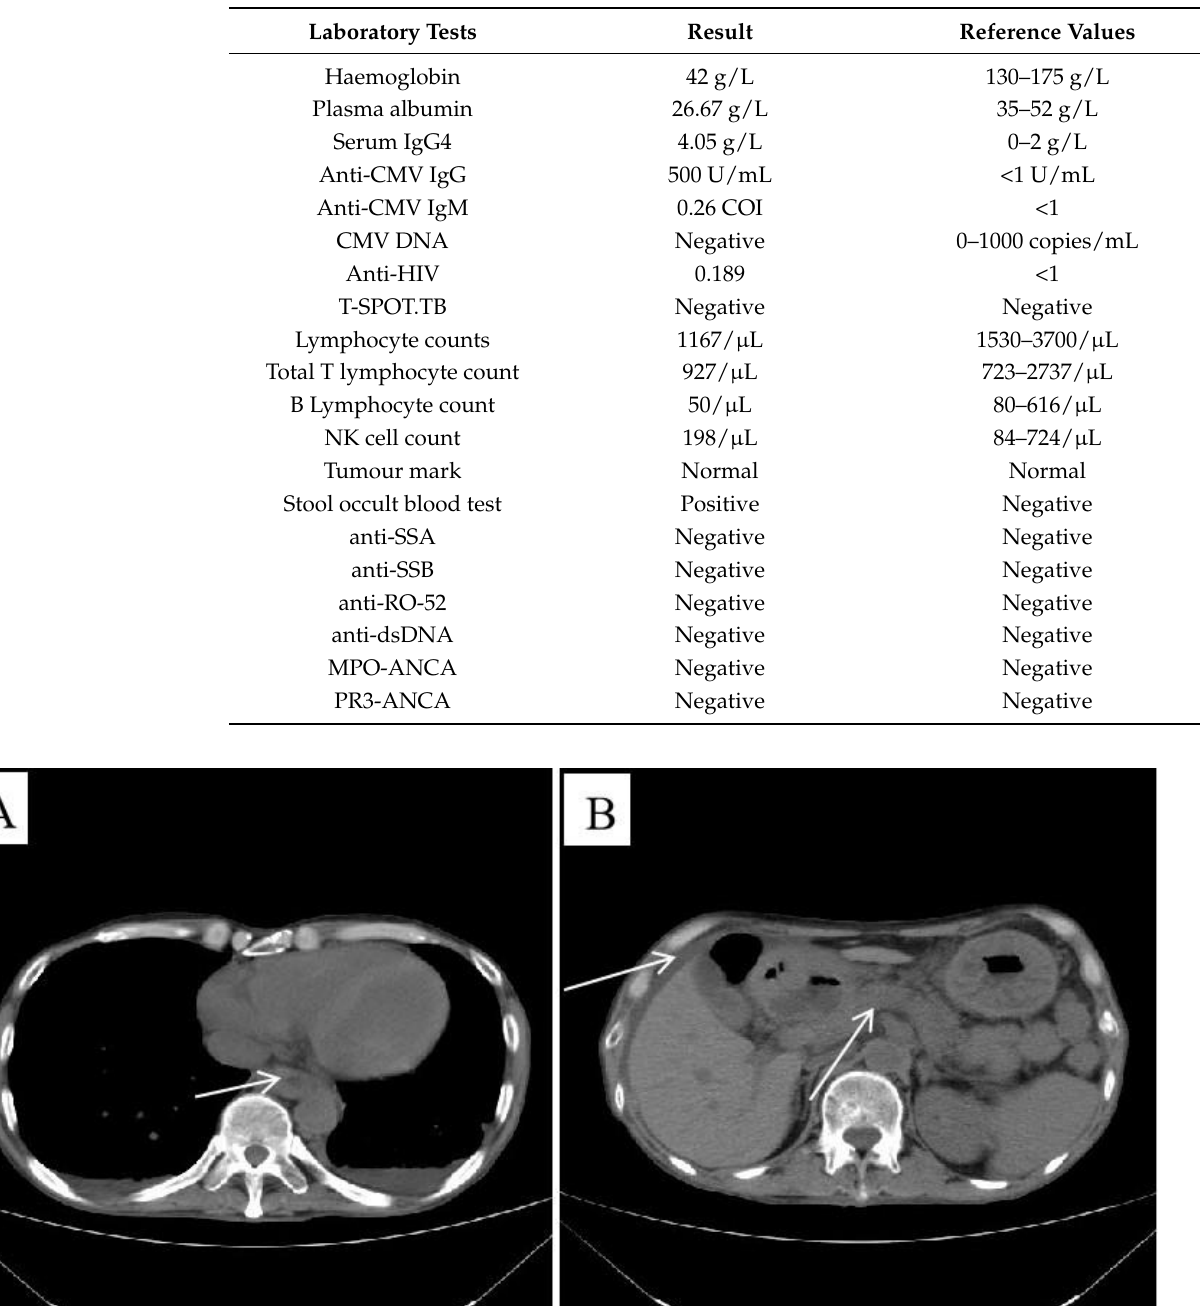
Table 1. Laboratory test results.